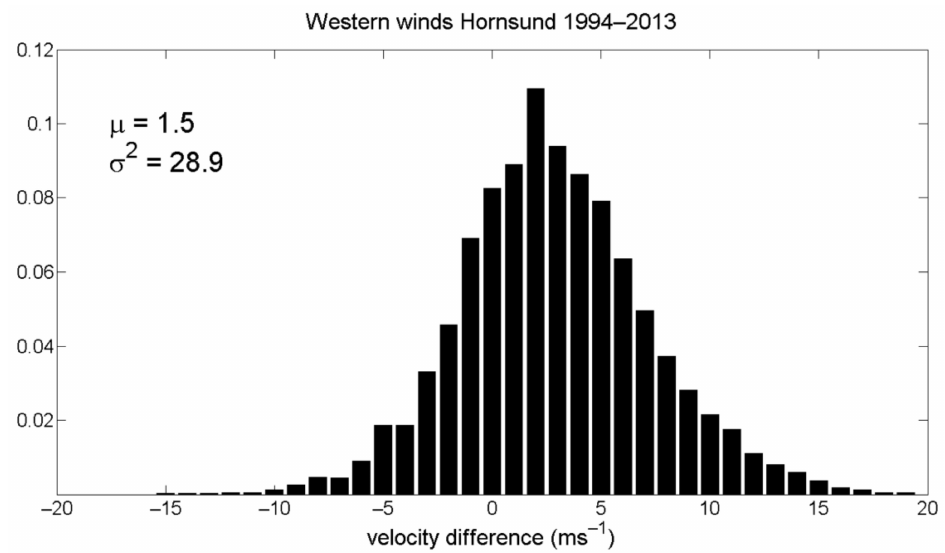
Figure 7. The histogram shows the distribution of the difference in wind speed from the reanalysis and speed measured at the Hornsund station for the period 1994–2013 when the winds in both scales were western.